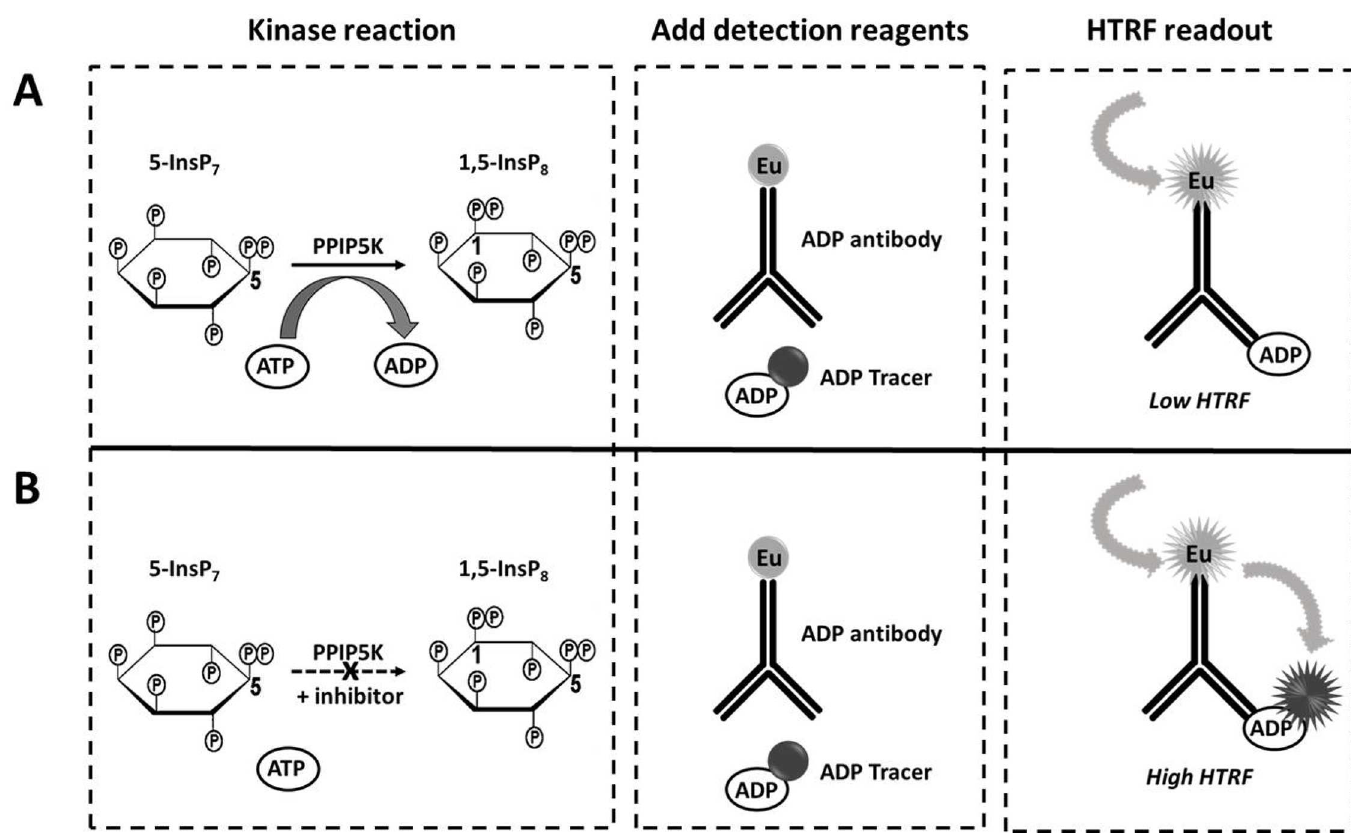
Fig 1. Schematic depicting the three phases of the HTS Assay for PPIP5K. The schematic describeshow the degree of PPIP5K activity is inversely proportional to the magnitudeof the HTRF signal. During the kinase reaction 5-InsP 7 phosphorylation to 1,5-InsP 8 is coupled to ATP conversion to ADP. After 60 minutes the kinase reactions are quenchedwith EDTA (not shown) and the ADP detection reagents are added. The HTRF signal is measured after another 30 minutes. (A) In the absence of inhibitorthere is productionof ADP, which competes with the ADP tracer for the ADP antibody, resulting in a low HTRF signal. (B) In the presence of inhibitor, ADP productionis decreasedthereby allowingADP tracer to bind to the ADP antibody, resulting in a high HTRF signal. The hypotheticalexamplesshown in (A) and (B) represent two extreme assay outcomes of 100% and 0% phosphorylation